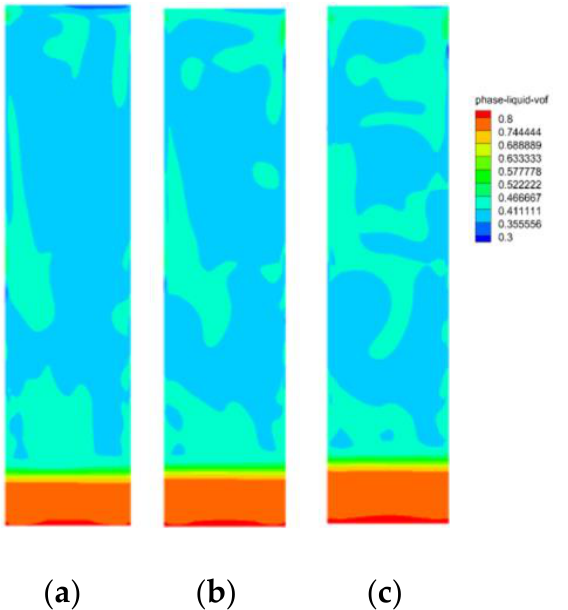
Figure 7. Distribution of the liquid volume fraction of xy-plane slice during the separation process at 30 s, where the surface tensions are σ = 0.04 ( a ), σ = 0.055 ( b ), σ = 0.07 ( c ), respectively.